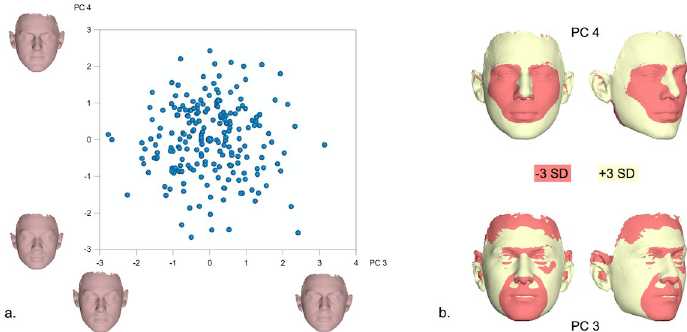
population. The superimpositions display the direction of shape variation explained by each PC.